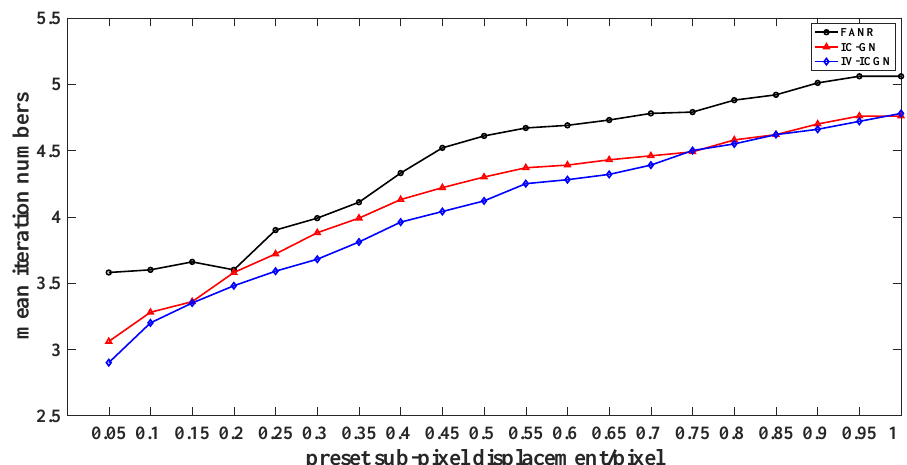
Figure 11. Comparison curve of number of iterations of algorithm IV-ICGN and algorithm